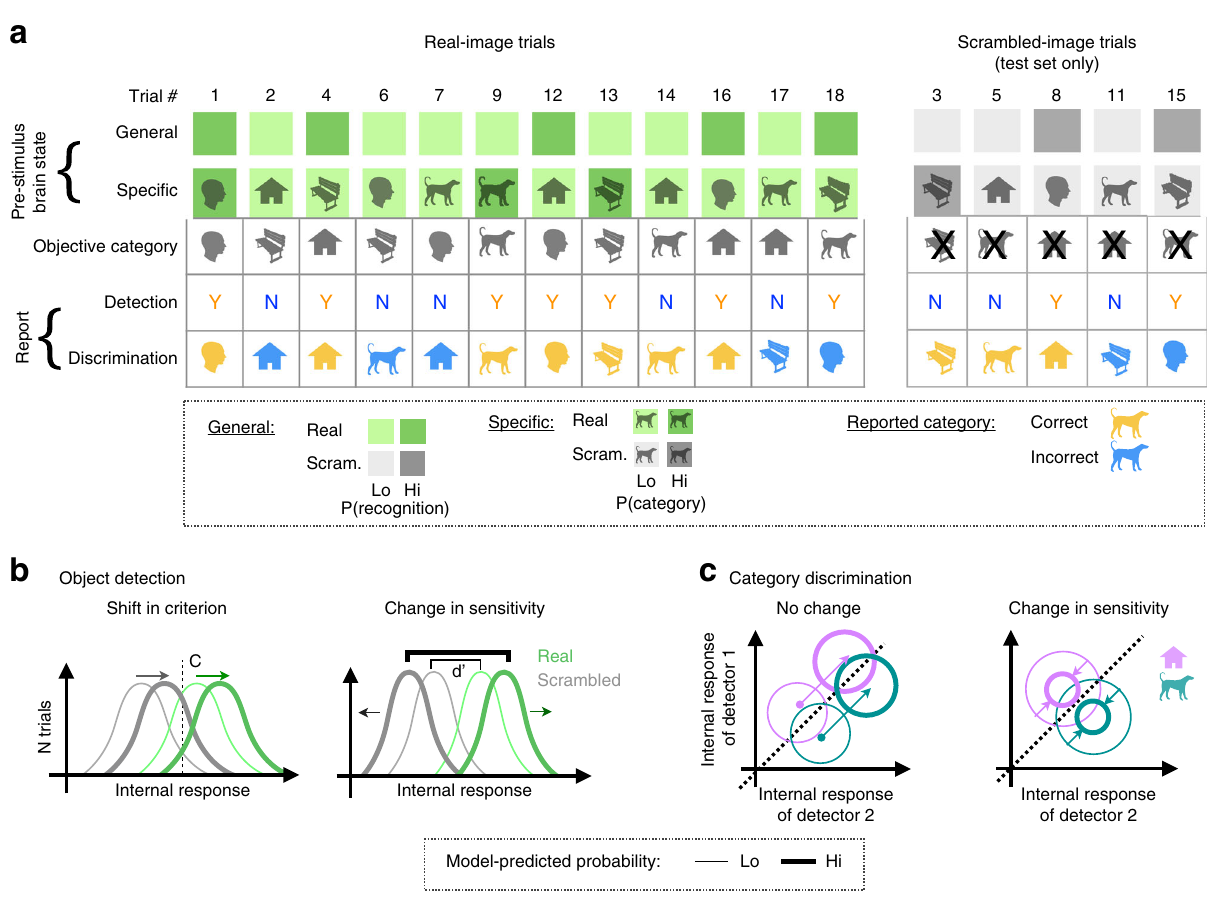
Fig. 3 Illustration of behavioral consequences of the General and Speci fi c spontaneous neural processes. a Illustration of single-trial predictions made by the General and Speci fi c neural process. According to the General model, pre-stimulus brain states in fl uence the probability of recognizing a forthcoming stimulus, P(recognition) , regardless of its category. According to the Speci fi c model, pre-stimulus brain states contain predictive information about objective stimulus category, P(category), which translates into a higher probability of recognition if valid (i.e., category predicted with the highest probability matches the objective stimulus category). The two shades of green/gray depict high (hi) and low (lo) probability predicted by each model trained in real- image trials. b The two models fi t within real-image trials may correlate with shifts in criterion and changes in sensitivity of object detection. The thick and thin lines depict high and low probability predicted by each model. c The two models fi t within real-image trials may correlate with changes in category discrimination of both real and scrambled-image trials. The thick and thin lines depict high and low probability predicted by each